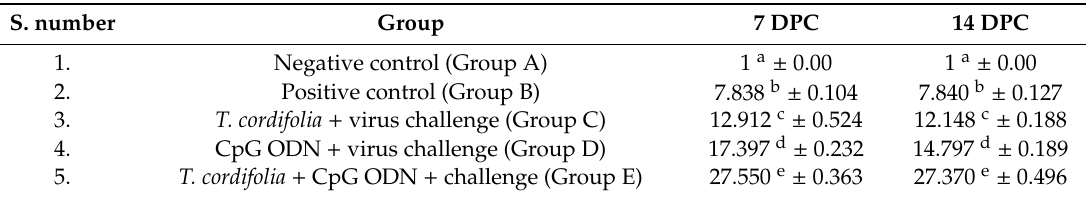
Table 7. Quantitative real time PCR analysis of IL-2 expression in the bursa of Fabricius of chickens challenged with vvIBDV at di ff erent DPC.